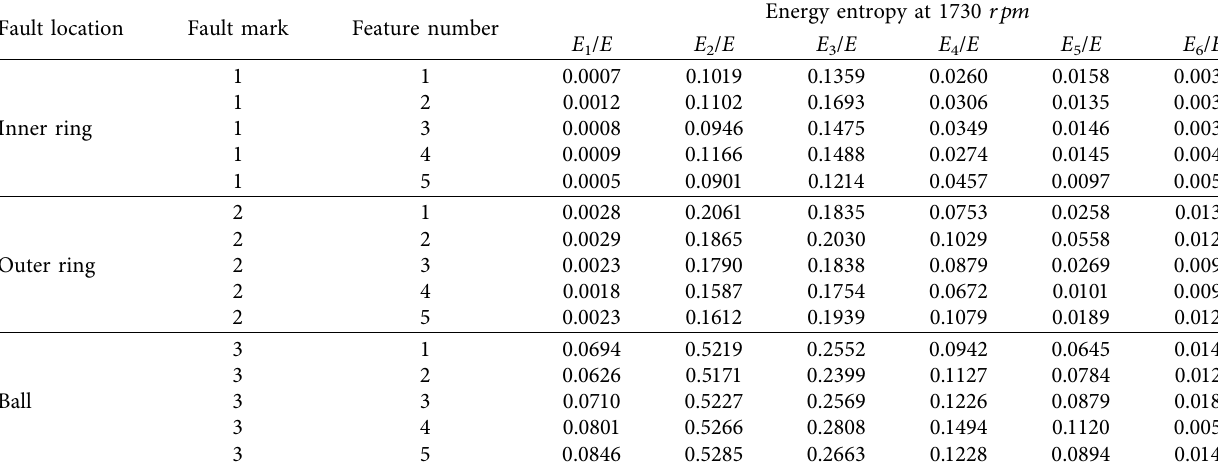
Figure 6: The IMF’s of sample. Table 1: Energy entropy at 1730